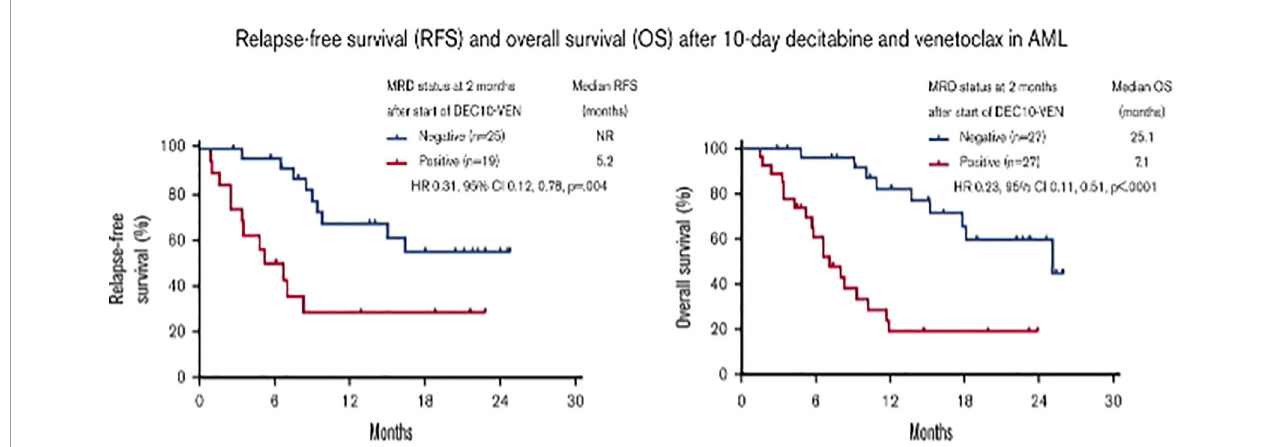
FIGURE 2 | Prognostic value of measurable residual disease after venetoclax and decitabine in acute myeloid leukemia (10). Figure from Maiti A, et al. Blood Adv 2021 (10). HR, hazard ratio; NR, not reached.